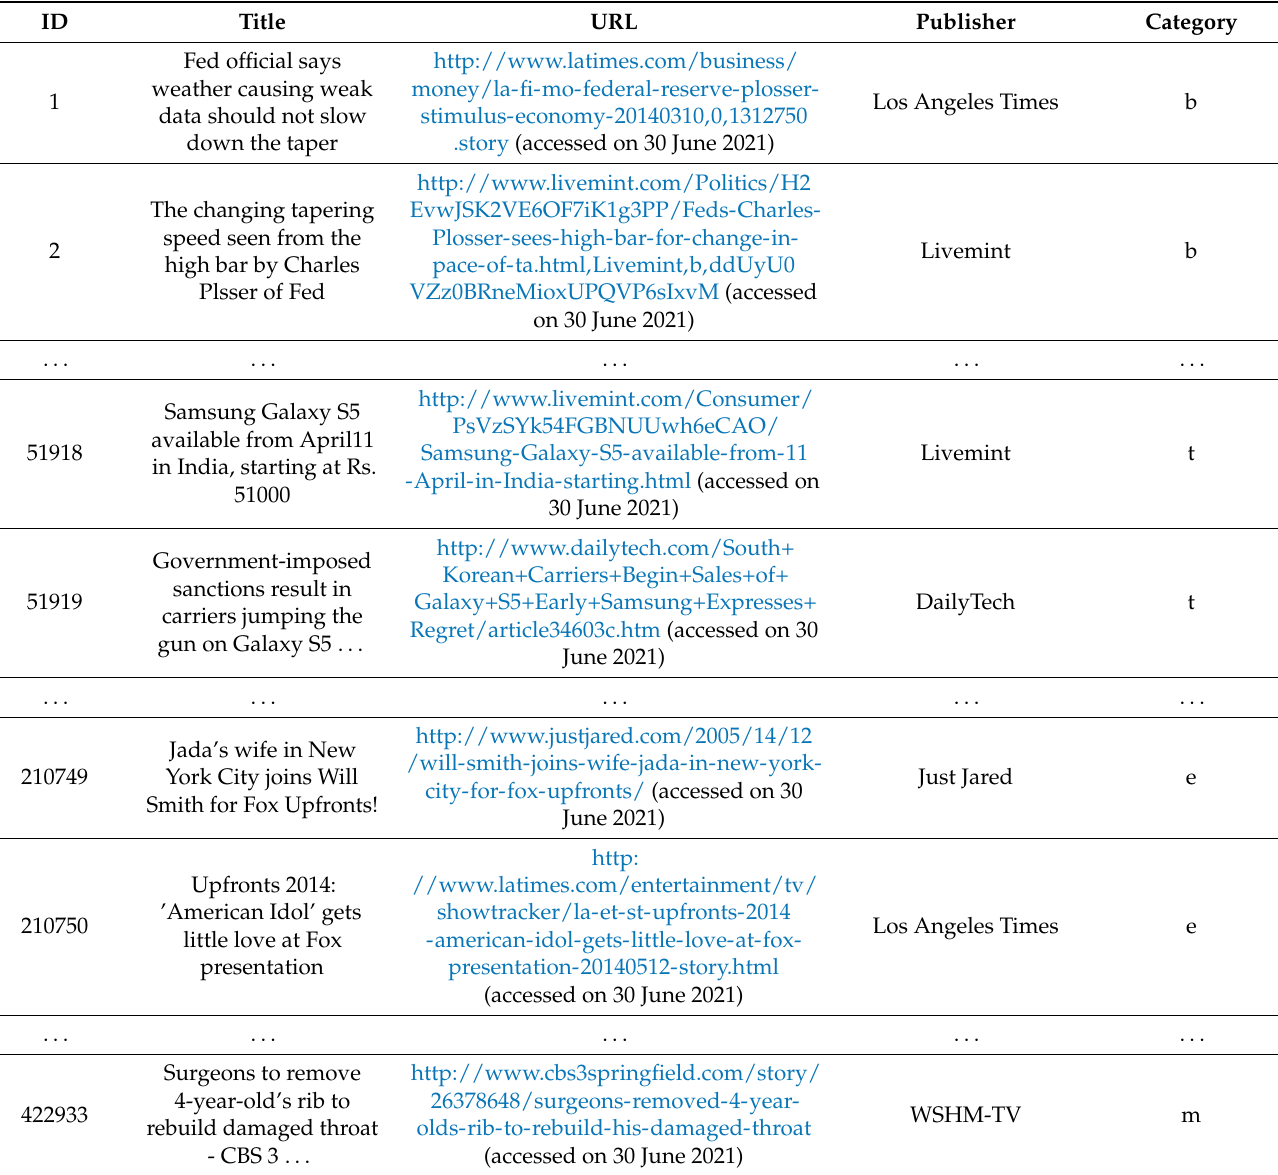
Table 2. Sample details of chatbot data input